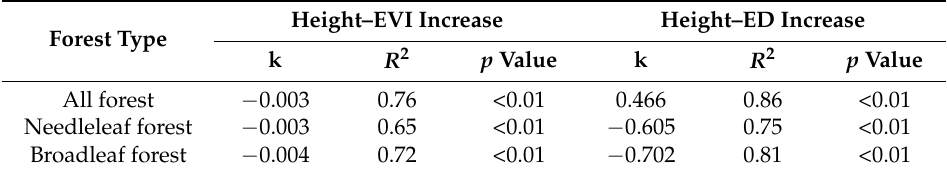
Table 1. The slope (k), coefficient of determination ( R 2 ), and statistical significance ( p value) of linear regressions between the increase of EVI Deficit (ED) and canopy height, and between enhanced vegetation index (EVI) and canopy height in different forest